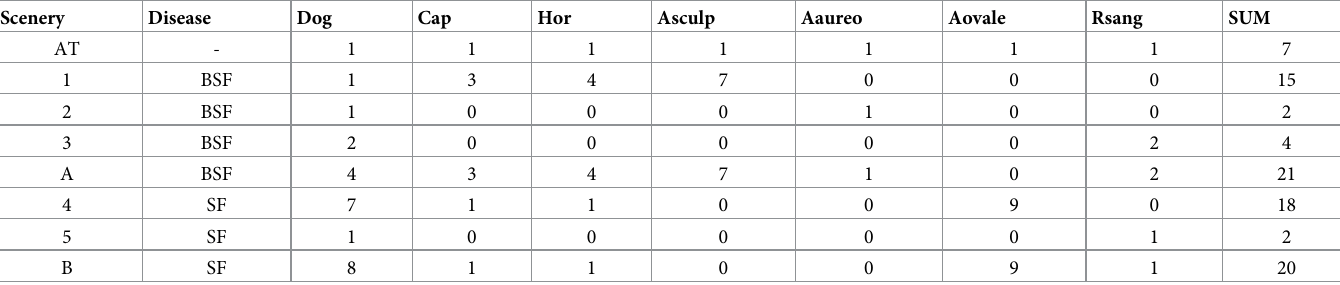
Dog—Canis familiaris, Cap—Hydrochoerus hydrochaeris, Hor—Equus spp., Asculp—Amblyomma sculptum, Aaureo—Amblyomma aureolatum, Aovale— Amblyomma ovale and Rsang—Rhipicephalus sanguineus. SUM—Total weights, Scenery AT (Aggregate Total)—Symptom severity scenery of entity compatible with spotted fever rickettsiosis, regardless of the etiological agent involved, considering all possibilities of host / vector interaction, Scenery 1—BSF Scenery considering the ecological relationship between the vector Amblyomma sculptum and its possible hosts (domestic dog, capybara and horse), Scenery 2—BSF Scenery considering the ecological relationship between the vector Amblyomma aureolatum and its main host, the domestic dog, Scenery 3—BSF Scenery considering the ecological relationship between the vector Rhipicephalus sanguineus and its main host, the domestic dog, Scenery A—BSF Scenery considering all possibilities of host / vector interaction, Scenery 4—Scenery of SF considering the ecological relationship between the vector Amblyomma ovale and its possible hosts (domestic dog, capybara and horse), Scenery 5—SF Scenery considering the ecological relationship between the vector Rhipicephalus sanguineus and its main host, the domestic dog, and Scenery B—SF Scenery considering all possibilities of host / vector